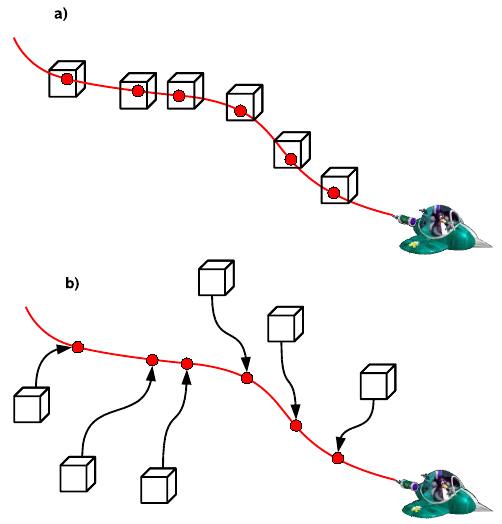
Fig. 3. Illustration of (a) the steady-state-mode, and (b) the tra- jectory mode of CAABA. The simulations start with conditions en- countered at the boxes, follow the black trajectories and end at the red dots which represent the measured data sets along the red flight